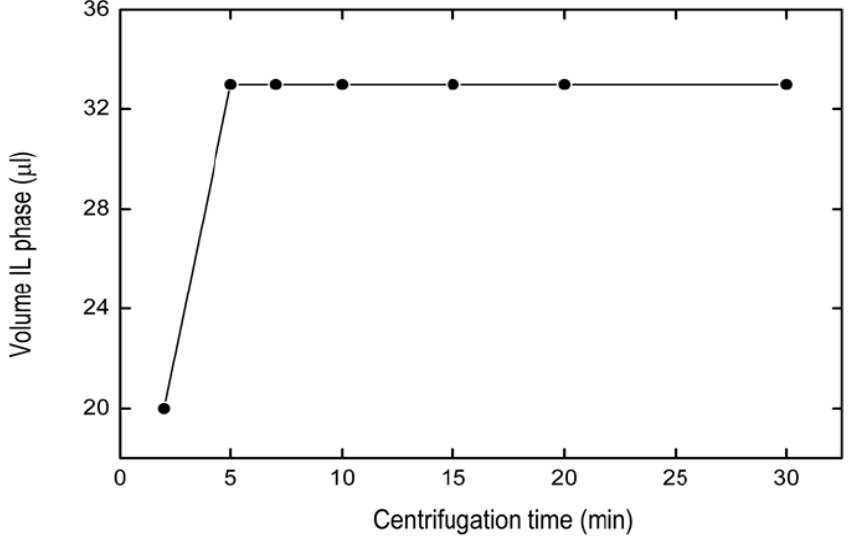
Figure 4. Effect of centrifugation time on volume IL phase. Solid line represents straight connectors.